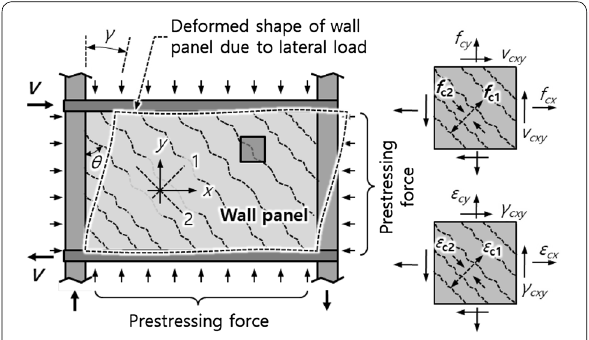
Fig. 10 Definition of biaxial stresses and strains of